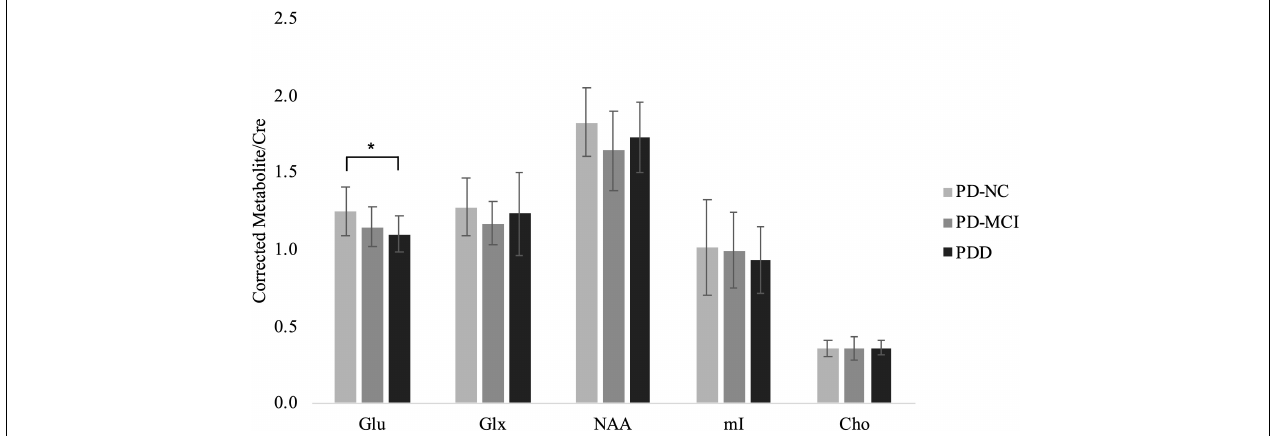
FIGURE 2 | CSF-corrected metabolite ratios to Creatine for the PD groups. Mean ± SD of metabolite ratio to Cre of Glu, Glx, NAA, mI, and Cho in the PD-NC, PD-MCI and PDD groups. Asterisk indicates significant group difference at p < 0.05.